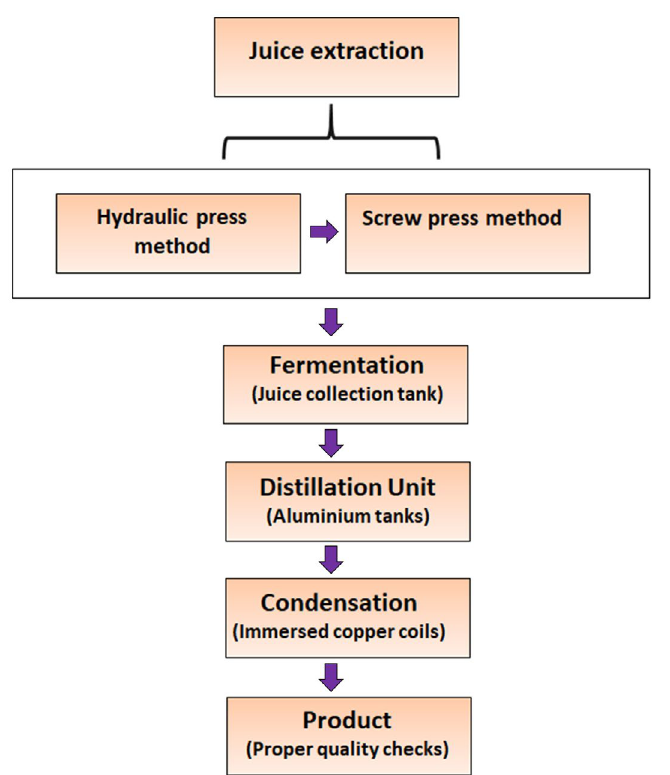
Fig. 5. Feni Production Process Involved in Production